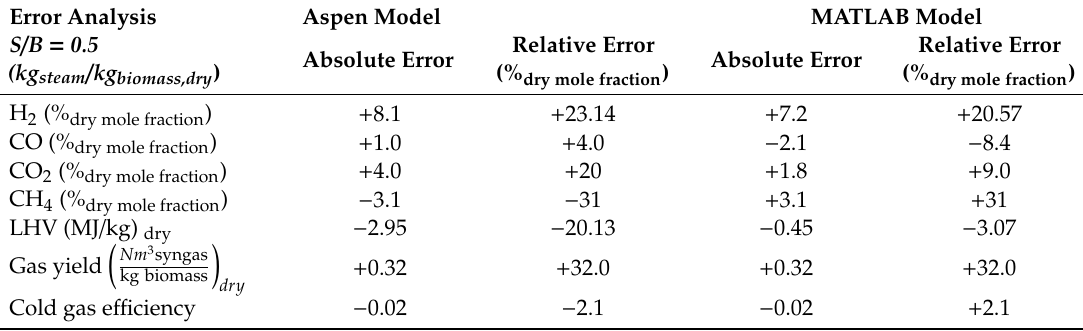
Table 6. Validation of syngas composition and characteristics (S / B =